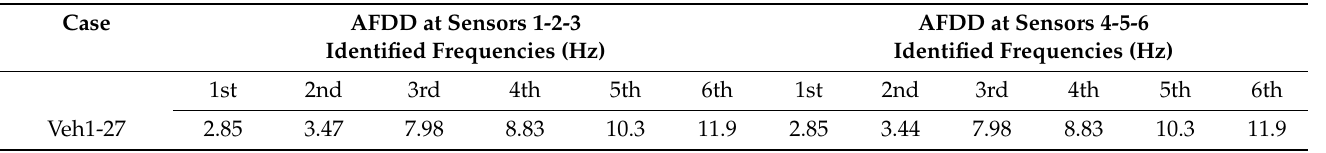
Table 14. Identified frequencies of numerical results with FDD method in the vertical direction (Z axis).